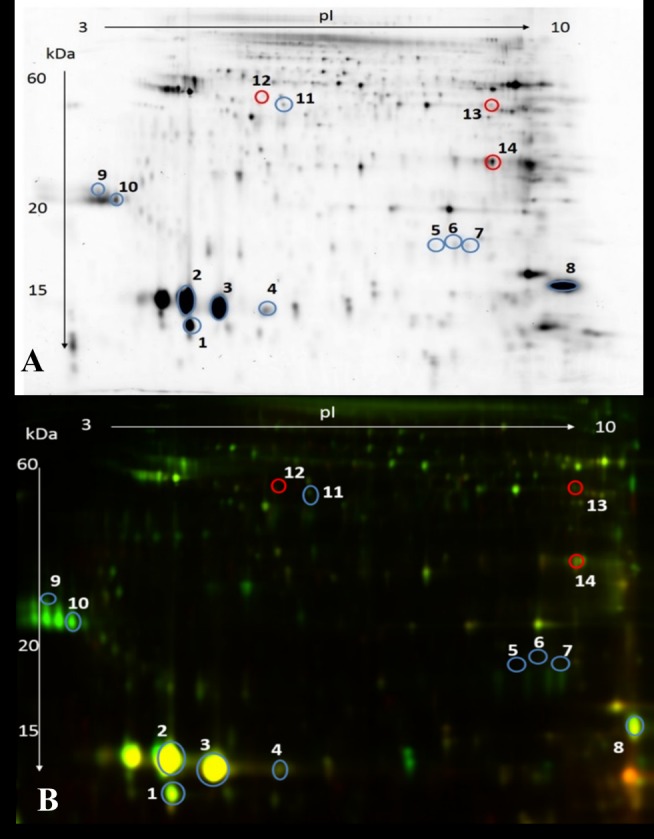
Two-dimensional differential electrophoresis gels showing the proteomic profiles of sperm from HQ and LQ bull ejaculates.Blue protein spots show a significant (p < 0.05) increase in abundance in HQ ejaculates and red protein spots show an increase in abundance in LQ ejaculates. The marked protein spots are numbered and listed in Table 2. Single channel representative image (A); and fluorescent overlay view (B).